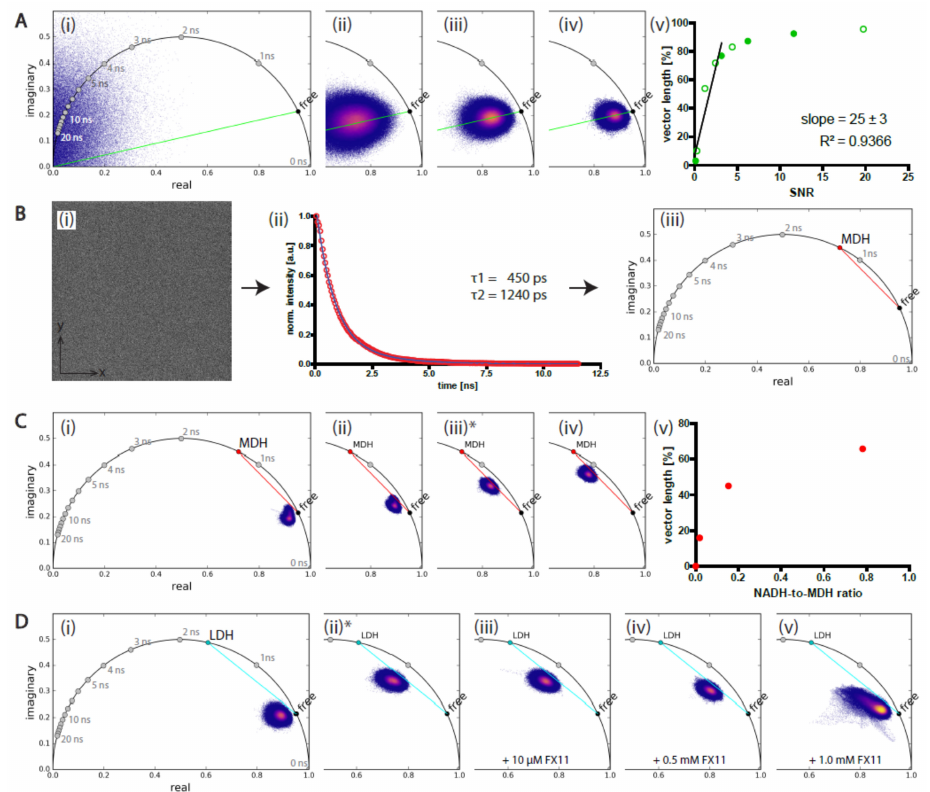
Figure 1. Benchmarking of NAD(P)H-FLIM data evaluated by the phasor approach. Phasor plots of mixtures of NADH and various enzymes solved. Gray dots onto half circle show the positions of 0 ns ≤ τ ≤ 20 ns in 1 ns-steps in phase domain. Phasor cloud: violet to orange–yellow false color representation of 3D histogram of phasor distribution; violet: low frequency; orange to yellow: increasing frequency, each dot in phasor plot has a counterpart in the xy fluorescence lifetime image. ( n = 3 measurements in the same sample). ( A ) NADH solved in MOPS medium: ( Ai ) only nonfluorescent MOPS medium (background BG), ( Aii ) 5 µ M, ( Aiii ) 10 µ M, and ( Aiv ) 20 µ M NADH. Green line indicates the phase vector pointing towards the position of free NADH onto the half circle. ( Av ) Graph displays signal–noise ratio (SNR) versus vector length in percent (as described in Results). The increase in SNR is caused by an increasing NADH concentration at constant excitation power. Filled circles indicates the data shown in panels ( Ai – iv ), blank circles represent results of the same experiments with other NADH solution concentrations. The line describes the linear regression of the displayed data points. ( B ) Strategy to determine the position of the phase vector of NAD(P)H bound to pure enzymes onto the half circle; here, 50 µ M NADH and 39.1 µ M MDH solved in MOPS medium: ( Bi ) homogeneous intensity image 512 × 512 pixel covering 200 µ m × 200 µ m, ( Bii ) averaged time domain decay curve over all pixel with biexponential fit, as line and data points (red circles)., ( Biii ) τ 2 was transferred to phase domain to mark MDH’s position onto the half circle (red dot), red vector connects position of free NADH and MDH bound to NADH. ( C ) Mixtures of NADH and MDH solved in MOPS medium: ( Ci) only 200 µ M NADH, ( Cii ) 132 µ M NADH and 2.6 µ M MDH [ratio MDH:NADH 0.019], ( Ciii ) 50 µ M NADH and 7.7 µ M MDH [0.154], and ( Civ ) 50 µ M NADH and 39.1 µ M MDH [0.782]. The position of NADH bound to MDH fluorescence lifetime was determinate as described in ( B ). ( Cv ) Graph displays MDH:NADH ratio vs. vector length [%]. Red dots indicate the data shown in ( Ci-iv ). ( D ) NADH, LDH, and FX11 solved in MOPS solution: ( Di ) only 50 µ M NADH; ( Dii ) 50 µ M NADH and 10 µ M LDH; ( Diii ) 50 µ M NADH, 10 µ M LDH, and 10 µ M FX11; ( Div ) 50 µ M NADH, 10 µ M LDH, and 0.5 mM FX11; and ( Dv ) 50 µ M NADH, 10 µ M LDH, and 1.0 mM FX11. The position of LDH lifetime was determined as described in ( B ) ( τ 2 = 1600 ps). After adding the LDH inhibitor, FX11, the experimental data cloud migrates back to free NADH with increasing FX11 concentration. The asterisks indicate the data sets used to calculate the SNR (Figure S3) as well as calculate τ 2 to mark the half circle. The cyan lines represent the trajectories on which the data cloud migrates if the enzyme activity